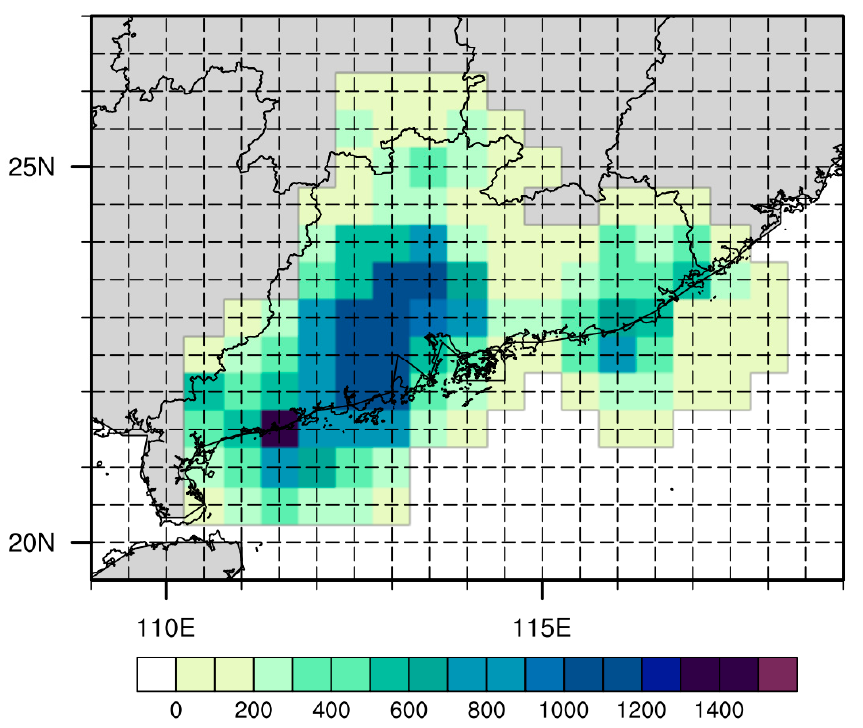
Figure 2. Spatial distribution of occurrence frequency of MVs during the first rainy season in Guangdong, South China, from 2017 to 2019.